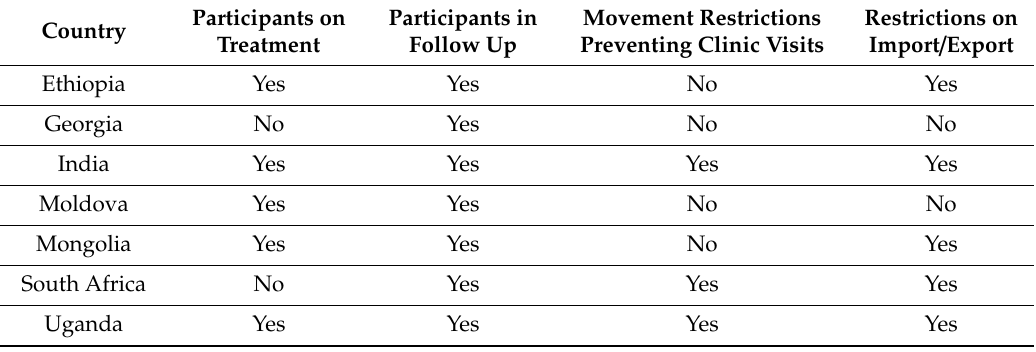
Table 1. STREAM Stage 2 countries and current status of participants and restrictions on travel and import /